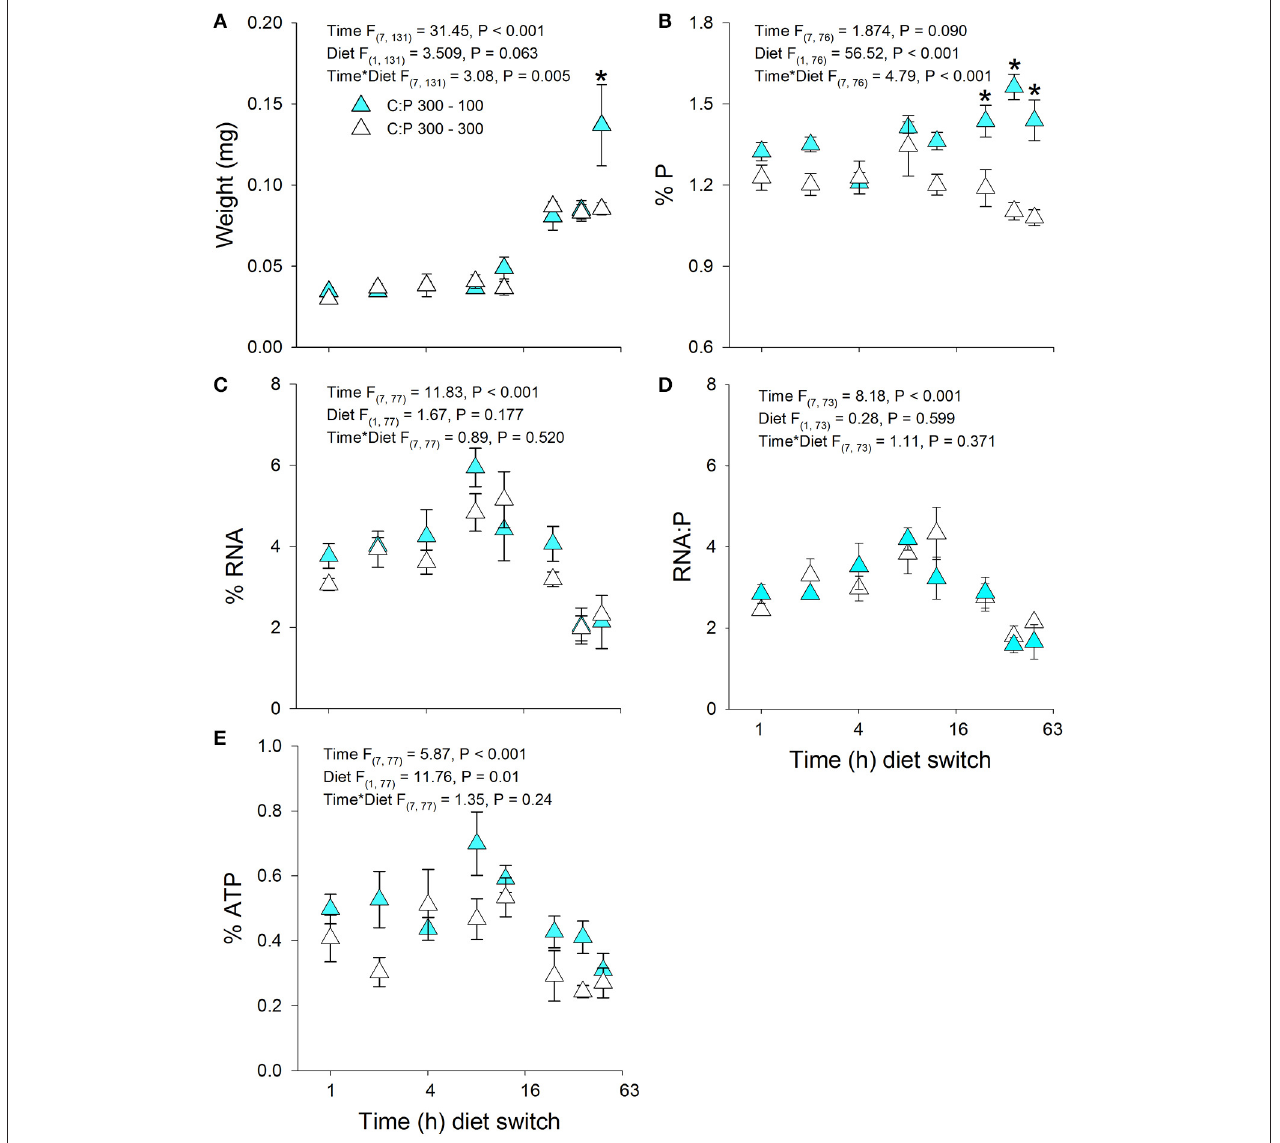
FIGURE 3 | Acute averages ± standard error in Daphnia mass (A) and metabolic P-pools ( B ; body %P, C ; body %RNA, D ; RNA:P, E ; body %ATP). White triangles are animals maintained at C:P 300 while cyan triangles representing animals that were switched to C:P 100 * indicates significant changes between switched diets and non-switched diets ( P <